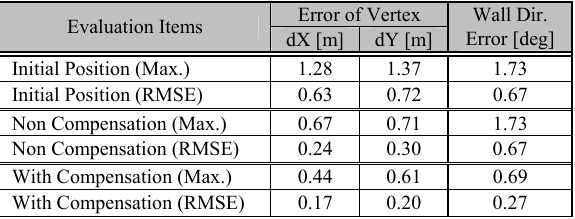
Table 3. Results of Wall Matching (vs. Manual Plotting)